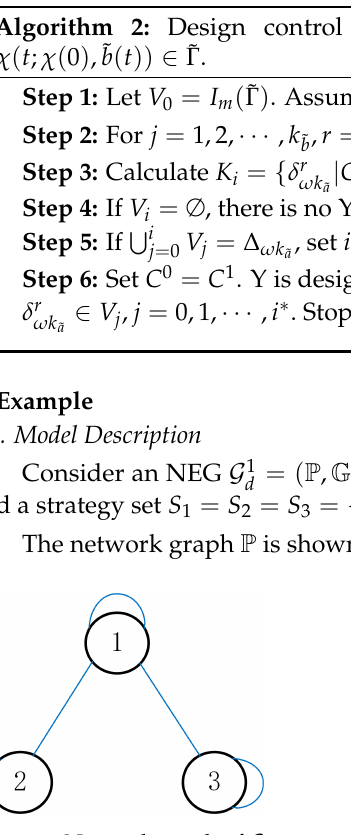
Figure 1. Network graph of G p .